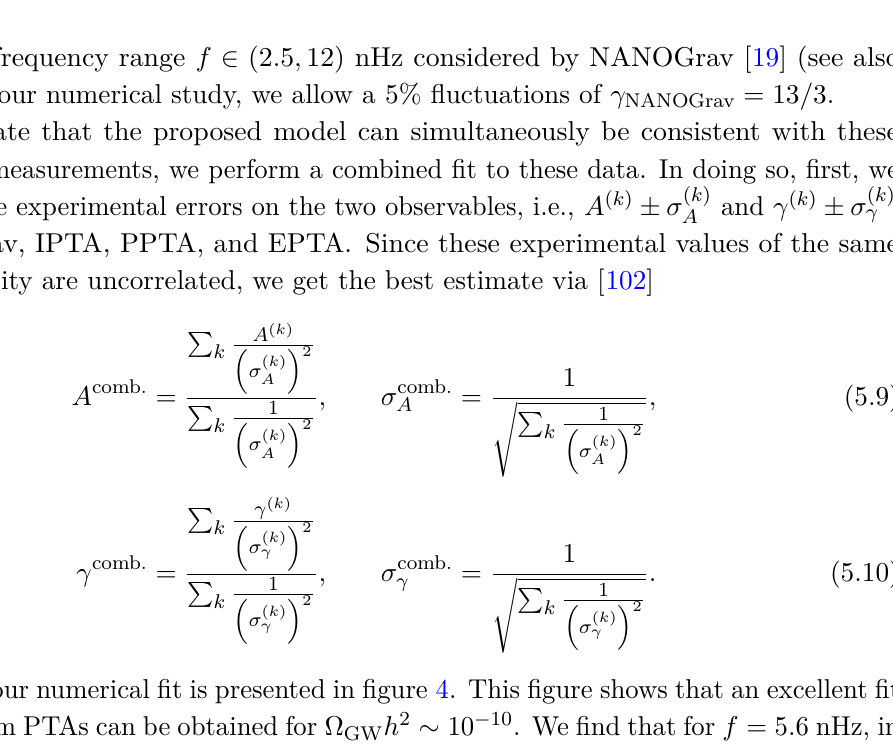
Table 3 . Experimentally allowed values of the characteristic strain amplitude and the spectral index at 95%